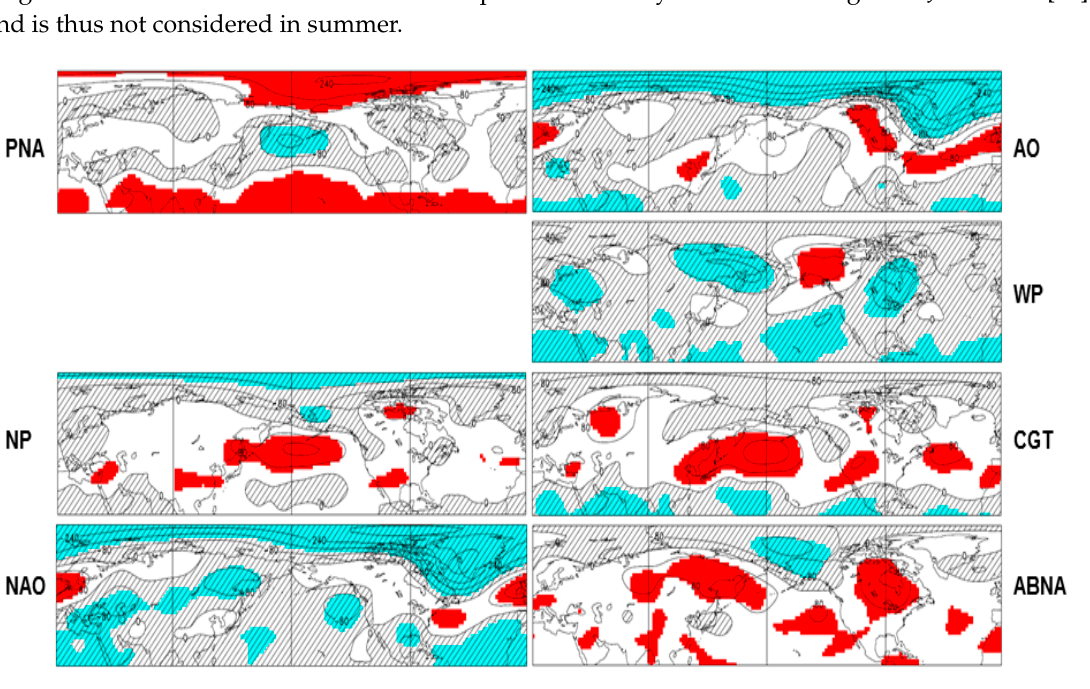
Figure 6. As in Figure 2, but for the JJA mean Φ 500 anomalies.